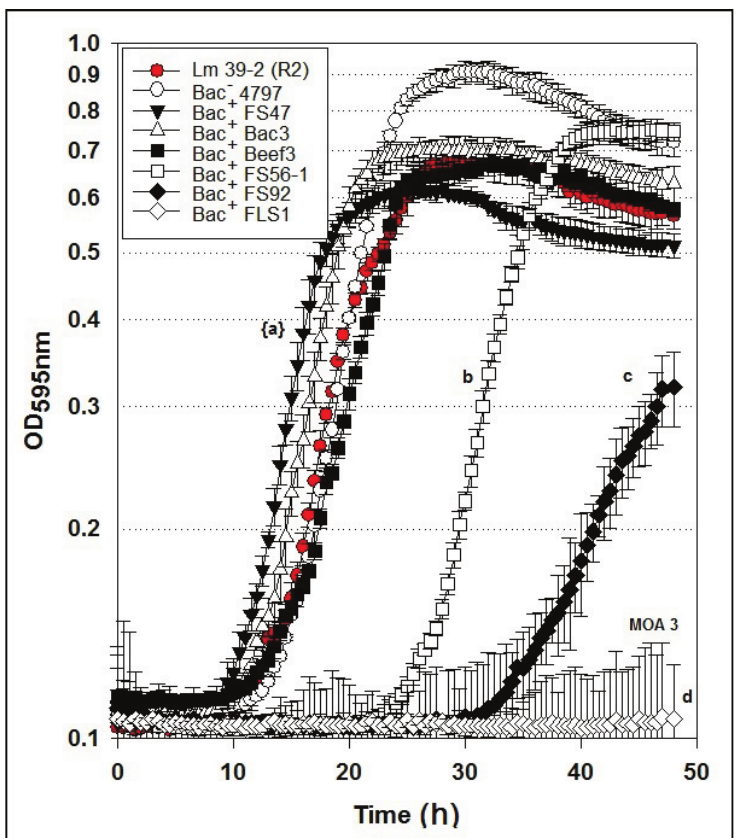
Figure A2. (Figure 6B with error bars) Growth inhibition assay showing the activity of Listeria monocytogenes 39-2 (R2) treated with culture supernatants from: None (R2 Cont.), Lb. delbrueckii 4797-2 (Bac (cid:2) ), Lb. curvatus FS47, P. acidilactici Bac3, Lb. curvatus Beef3, En. faecium FS56-1, En. thailandicus FS92, and Lc. lactis FLS1. Growth inhibition assay using neutralized culture supernatants. Data points represent the means of triplicate replications and error bars represent the standard deviations from the means (error bars were not used for all curves in the main paper to prevent clutter). Treatments with different lowercase letters are significantly different ( p < 0.05); letters in brackets are for entire group of graph